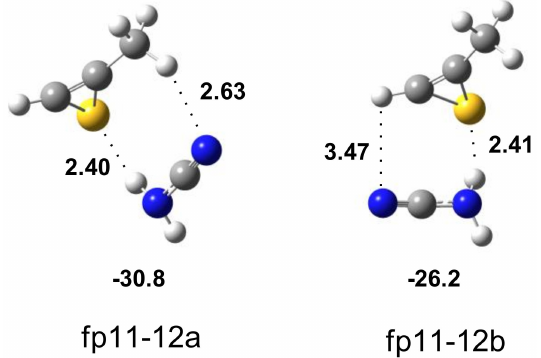
Figure 5. B3LYP/6-311++G(3df,3pd) optimized structures of the H 2 N–C ≡ N ··· CH 3 -CSC–H